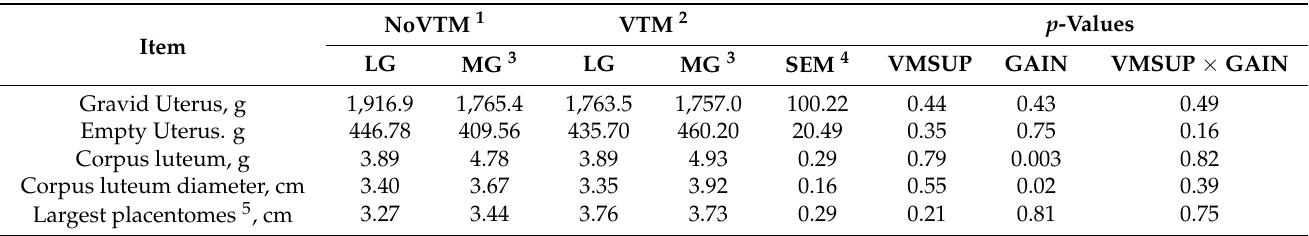
Table 6. Effect of feeding a vitamin and mineral supplement [VMSUP; not supplemented (NoVTM) or supplemented (VTM)] and two different rates of gain [GAIN; low rate, 0.28 kg/d (LG) or moderate rate, 0.79 kg/d (MG)] to beef heifers during the first trimester of gestation on dam reproductive tract characteristics at day 83 ± 0.27 of gestation.